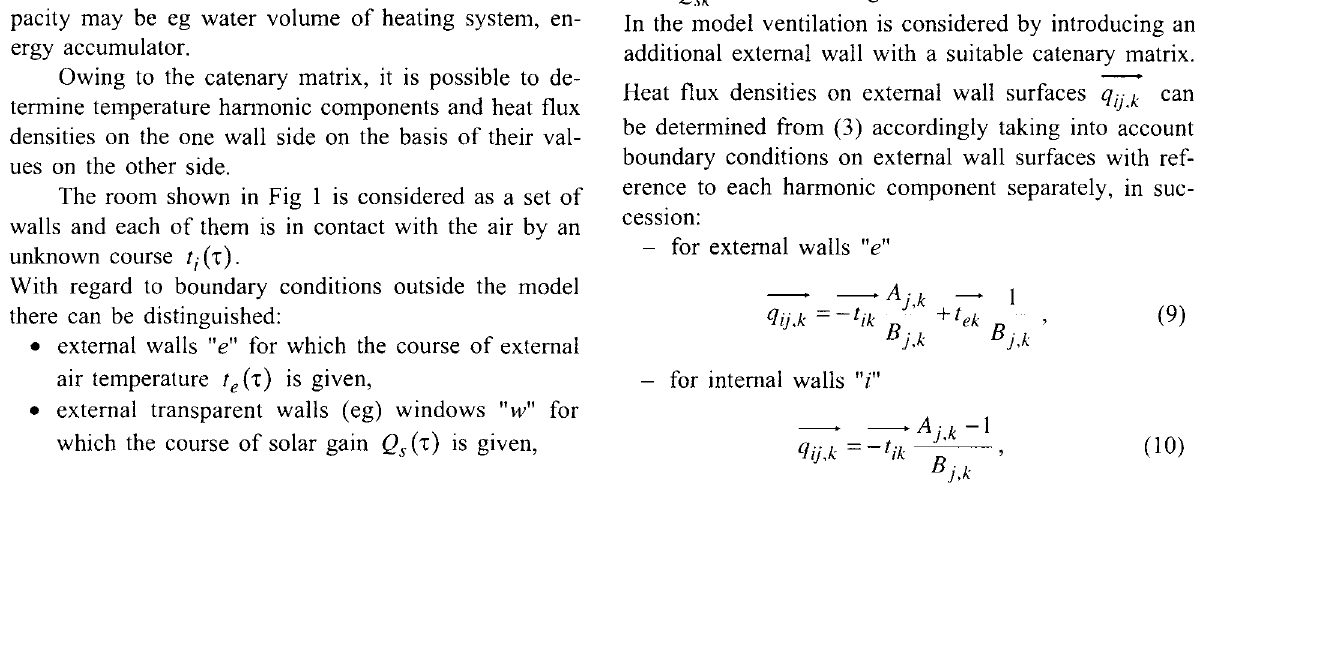
Fig 2. The section of plane heater In relation to each harmonic component the heat balance equation of the air in the room should be